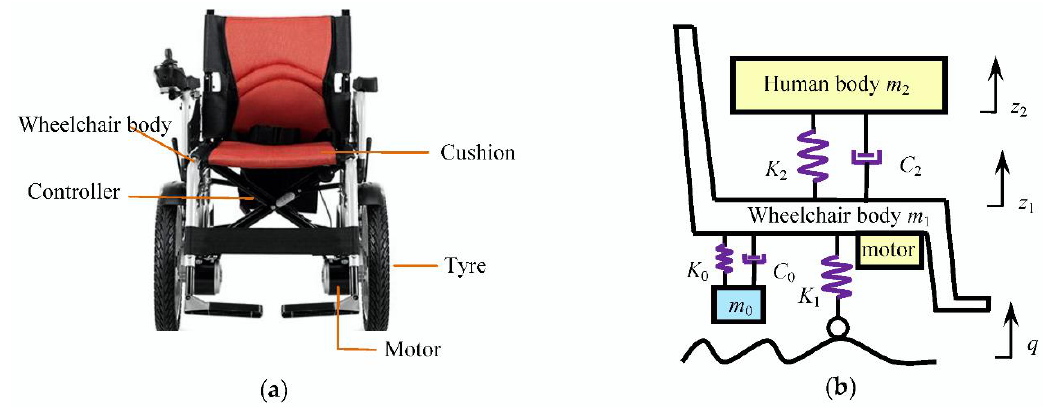
Figure 1. The electric wheelchair: ( a ) a commercial product; ( b ) the vibration model.